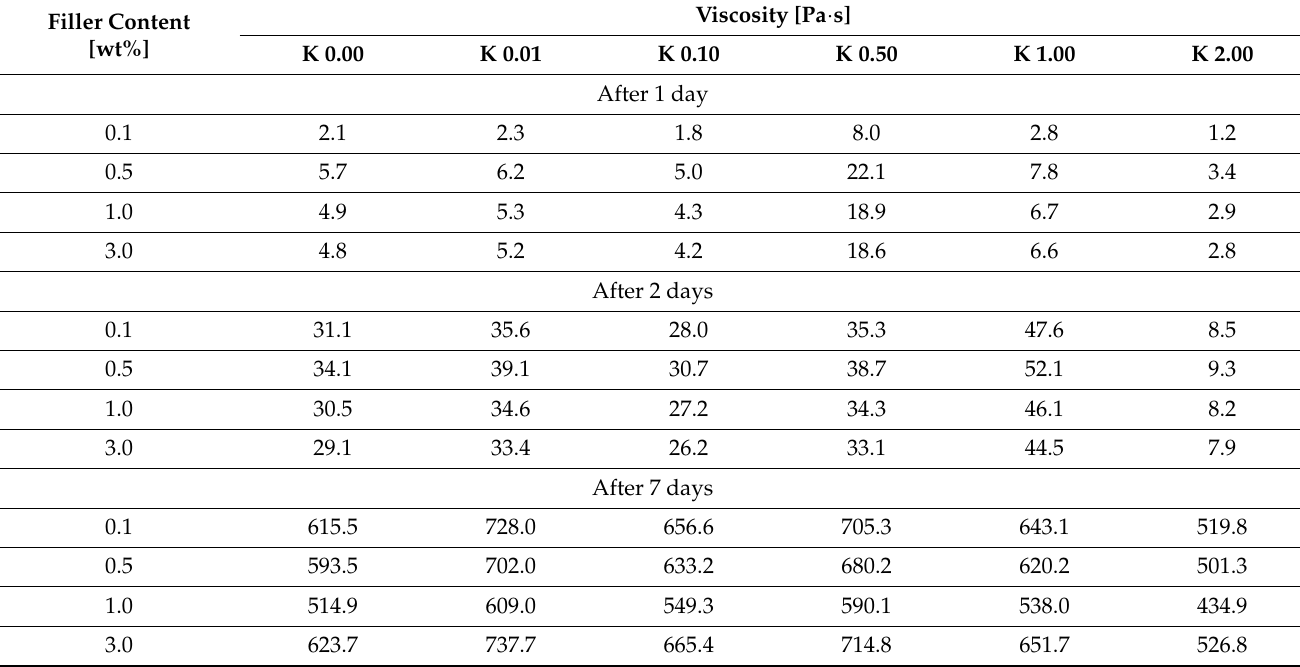
Table 4. The viscosity of Q2-7355 resin-based compositions with